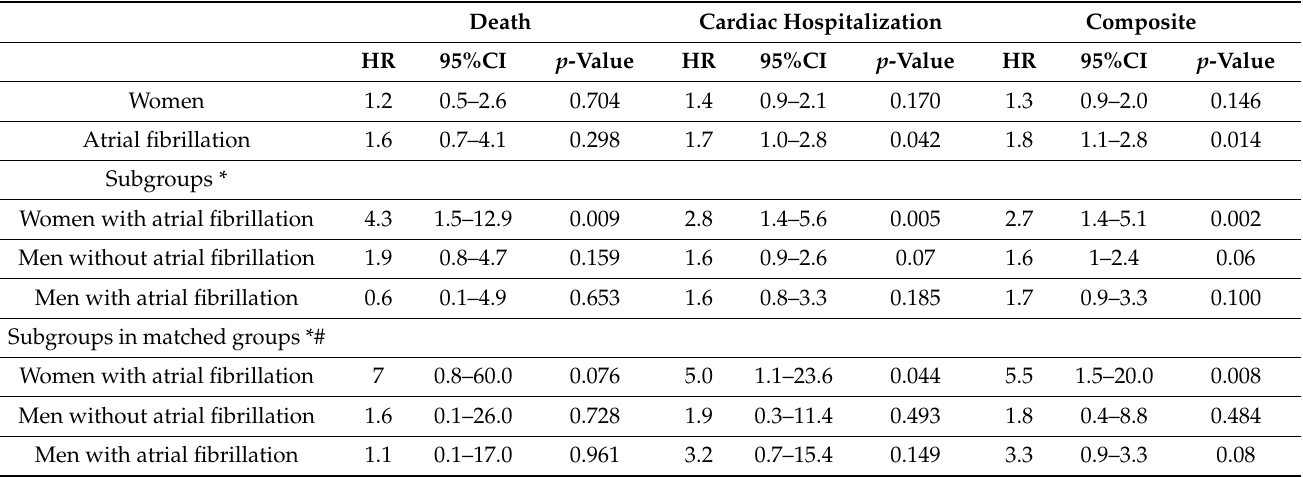
Table 3. Cox regression analysis for the prediction of outcomes.